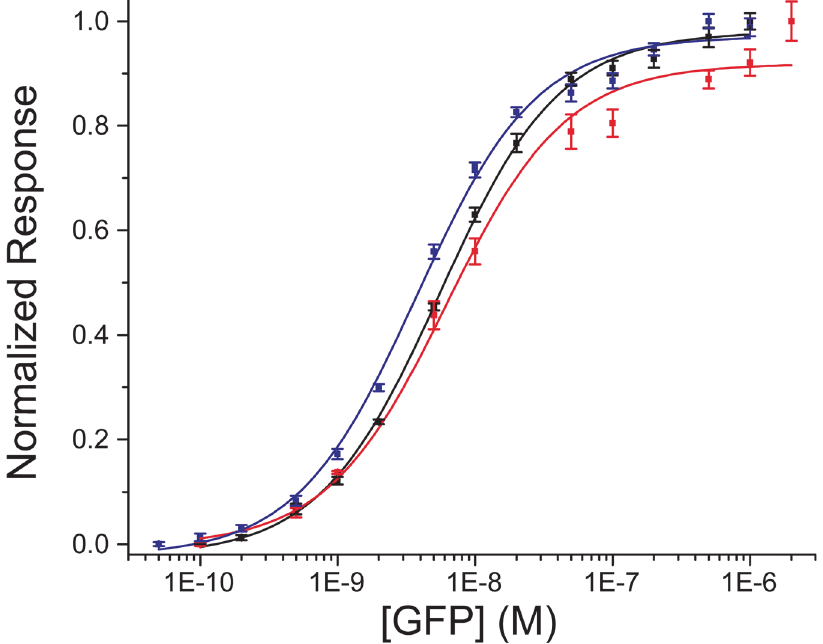
Fig 4. Endpoint response of the reference subtracted binding curves of the GFP:GFP-Nb interaction as function of GFP concentration. The red, blue and black squares are the raw data collected for the Ni: NTA, the anti-polyhistidine and the CAP chip respectively, and the lines are the best fit of the data set to the Hill ’ s equation (R 2 = 0.99).